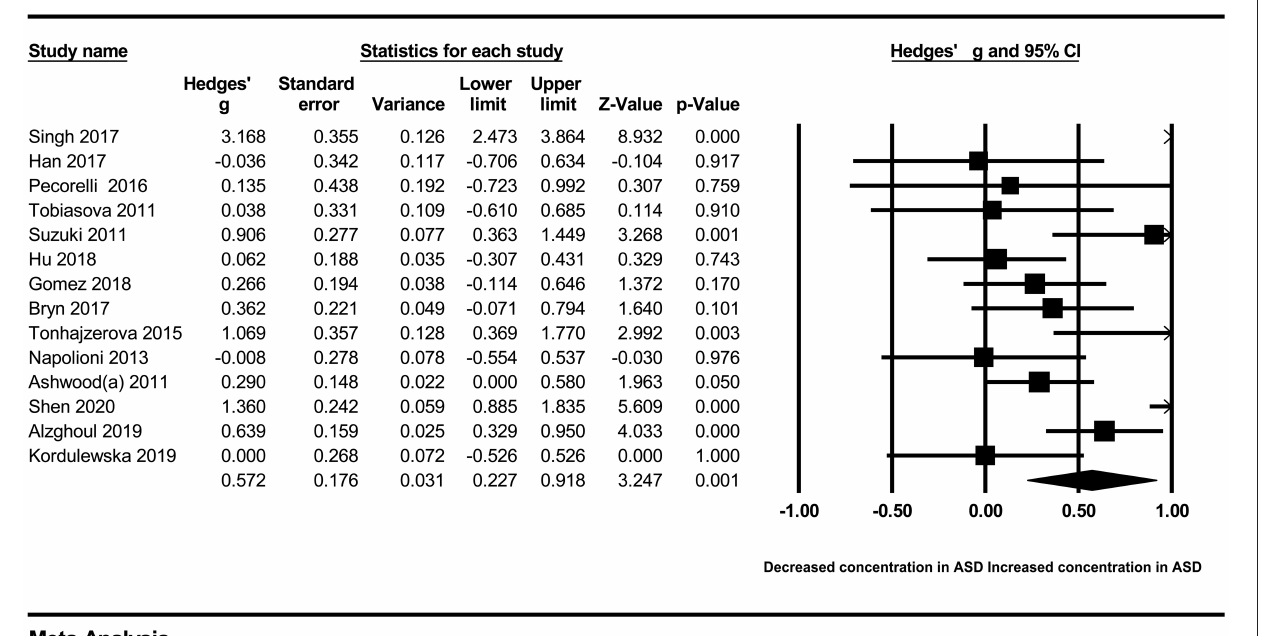
FIGURE 8 | Forest plot for the random-effects meta-analysis